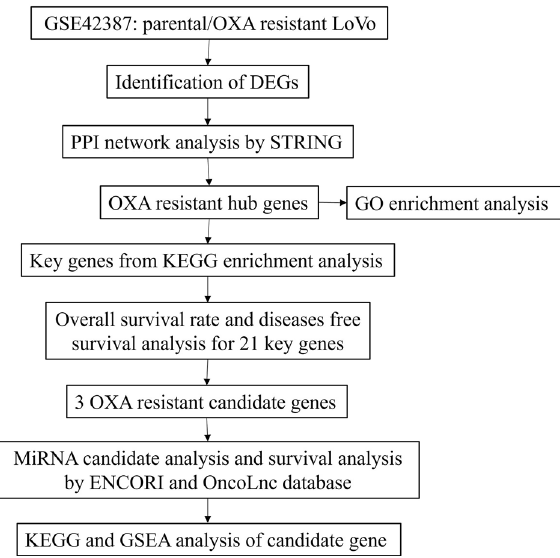
Figure 1. The flowchart of the bioinformatics